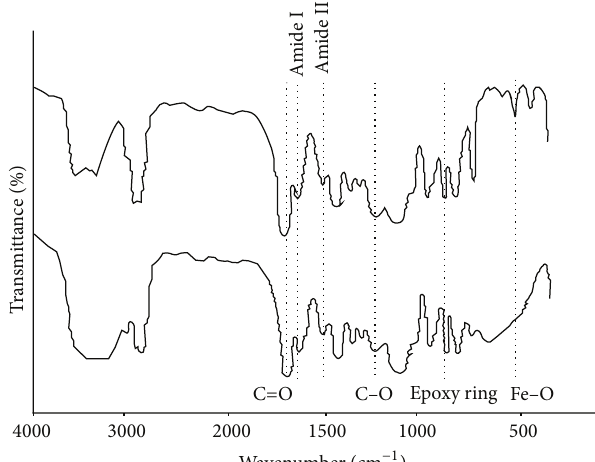
Figure 2: FTIR spectra of (a) magnetic copolymer GN73 and (b) copolymer GN73.